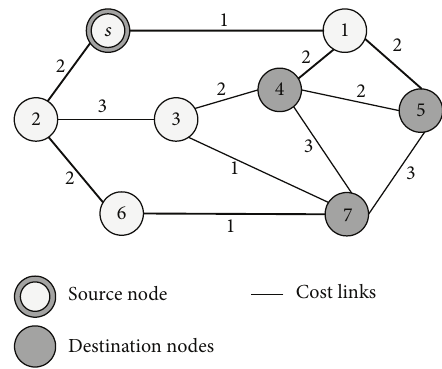
Figure 2: An example of a weighted undirected graph for multicast